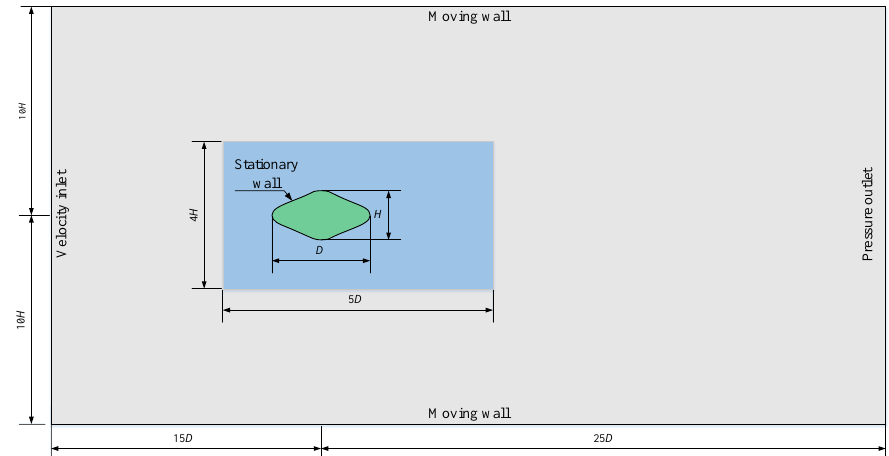
Figure 4. The computational domain and boundary conditions used for CFD simulation. The left wall is set as velocity inlet with a fixed horizontal velocity value, and the right wall is set as pressure outlet. The top and bottom is set as moving walls with the same value of inlet velocity due to the wide computational zone adopted in this paper. The AUH model edge is set as stationary